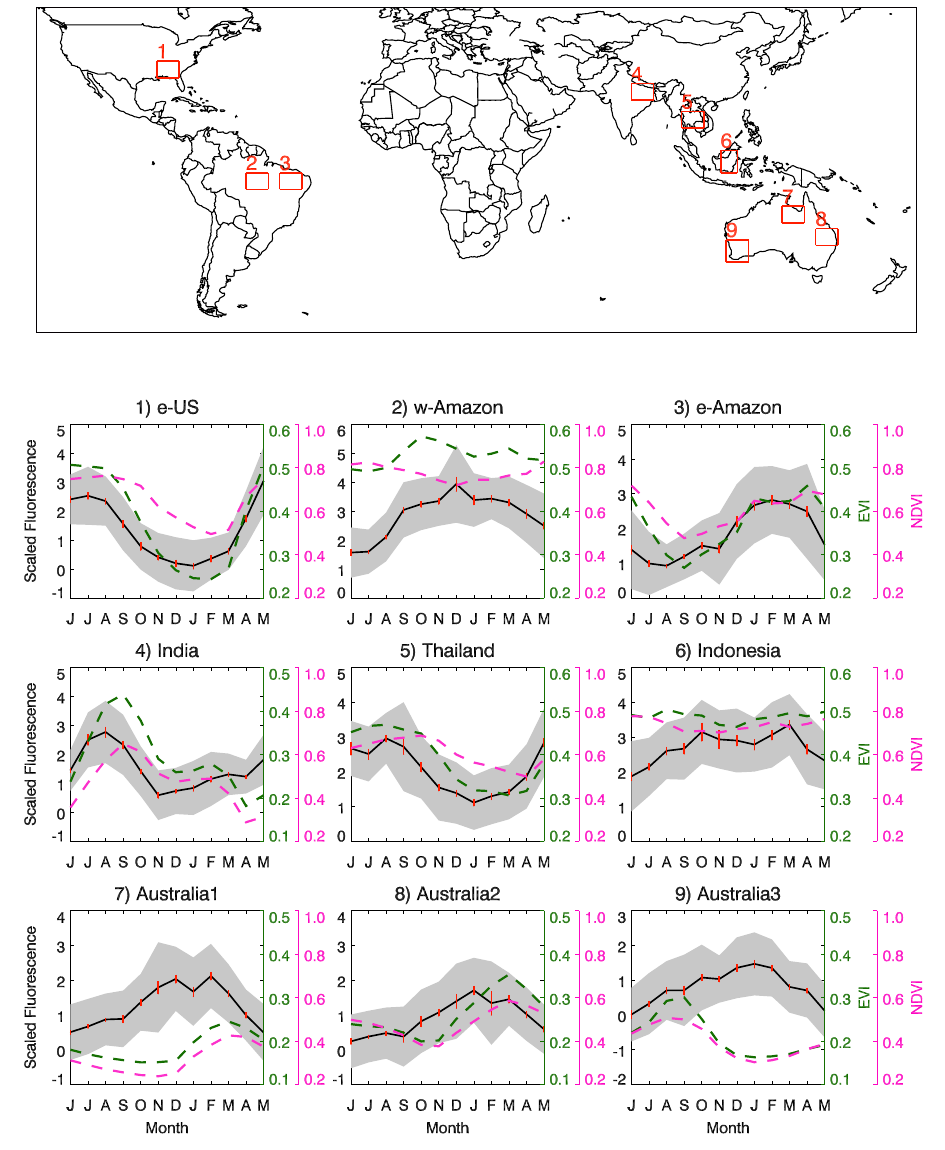
Fig. 12. Bottom panel: full seasonal cycle in scaled F from the P polarization for June 2009–May 2010 (left axis, unitless) for the regions indicated in the top panel; black line: monthly means; red line: errors of the mean; Shaded gray: standard deviation; dashed green (pink) line: MODIS EVI(NDVI) (right axes, unitless). 38